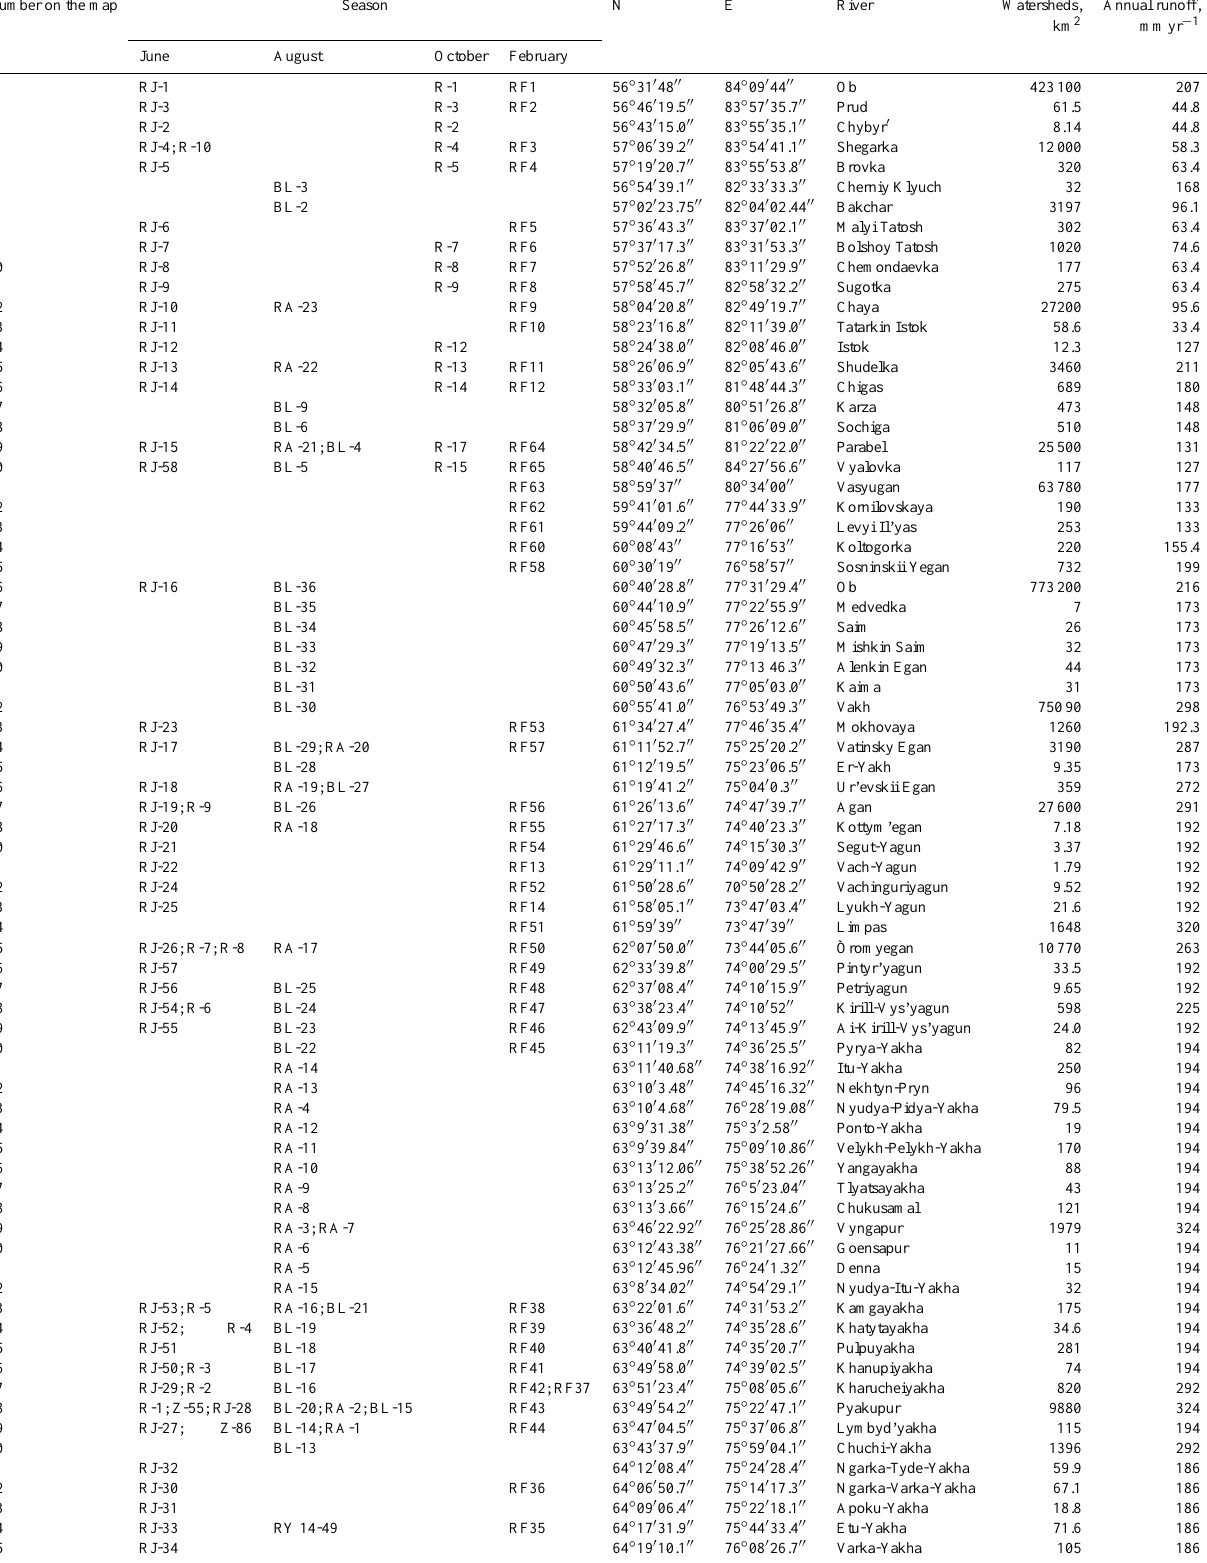
Table 1. List of sampled rivers, their watershed area and annual runoff. The codes under the months identify the sampling sites listed in Table S1 in the Supplement. The annual runoff was calculated following the approach of Frey et al. (2007b) as explained in Supplement 1. Number on the